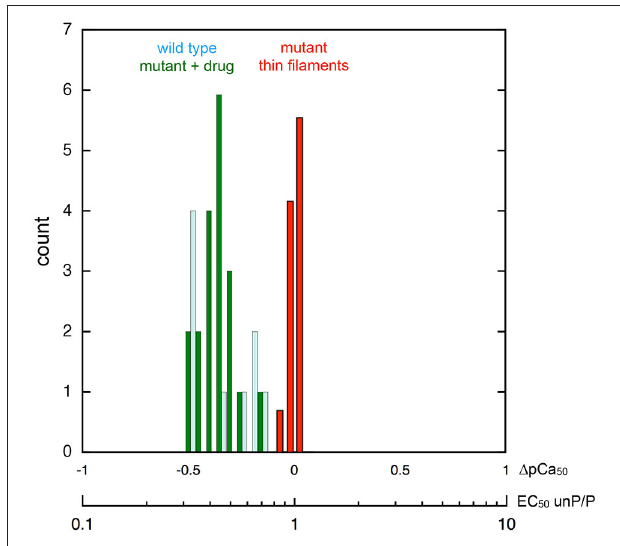
FIGURE 3 | Phosphorylation-dependent change in thin filament Ca 2 + -sensitivity. Frequency histogram showing the distribution of the ratio of Ca 2 + -sensitivity in the phosphorylated and unphosphorylated state. The X-axes shows the ratio of EC 50 unphosphorylated/phosphorylated and the corresponding shift in pCa 50 . Collected data from different mutations ( Figure 1 ) and different recoupling compounds ( Figure 2 ) is plotted. Red bars show distribution of shift in Ca 2 + sensitivity on phosphorylation for mutant thin filament samples ( n = 22 measurements by in vitro motility assay) showing no difference in Ca 2 + sensitivity (uncoupling). Dark green bars show distribution of Ca 2 + sensitivity shift from the same samples following the addition of small molecule recouplers. For comparison, the Ca 2 + -sensitivity shift on phosphorylation of native thin filaments and skinned muscle using a range of measurement systems is plotted (pale blue bars; n = 9, data from Marston, 2016, Table